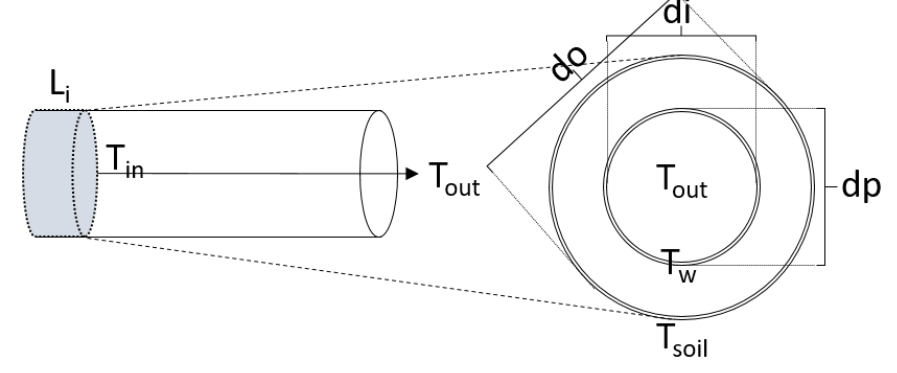
Figure 2. Principle components of the pipe